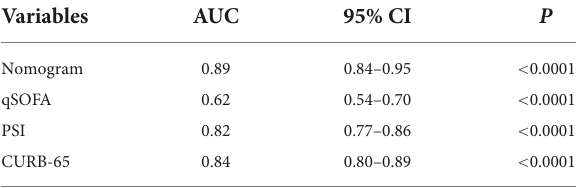
TABLE 6 The AUC of nomogram, PSI, CURB-65, and qSOFA for mortality in validation cohort.